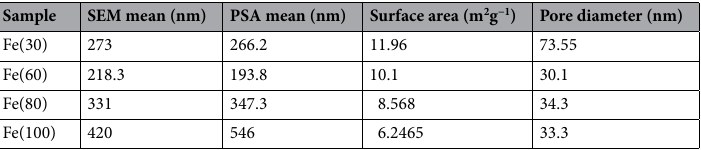
Table 3. Mean particle sizes of microwave synthesized samples measured by PSA and manually from